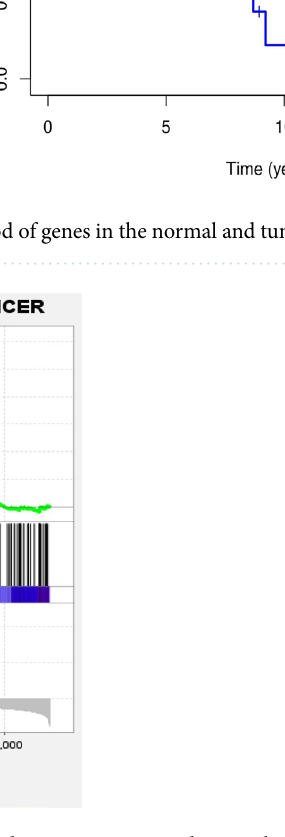
Figure 5. Enriched gene sets in small cell lung cancer, the KEGG gene sets, by samples of high gene